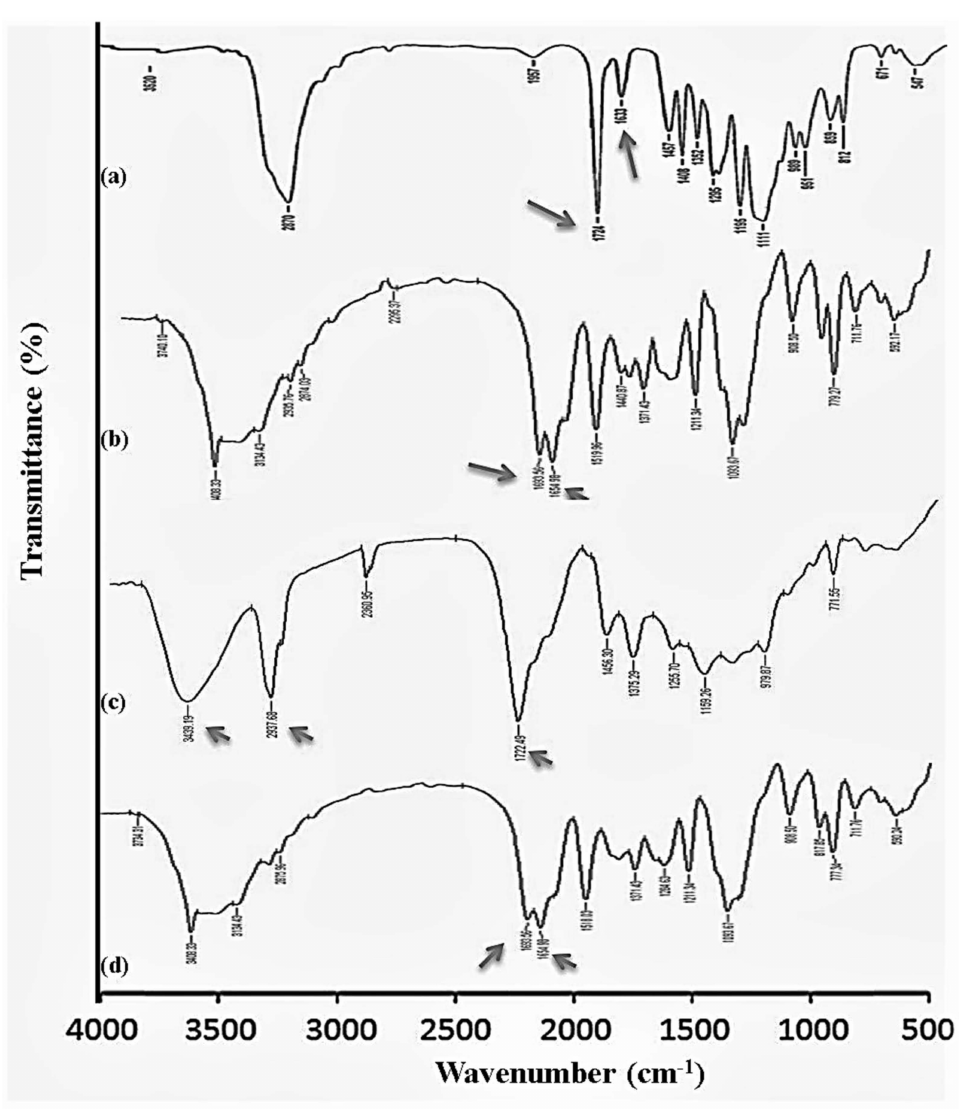
Figure 6. FTIR spectrum ( a ) Polyethylene glycol diacrylate (PEGDA) ( b ) gemcitabine ( c ) sodium carboxymethyl cellulose (NaCMC) ( d ) mixture of gemcitabine and